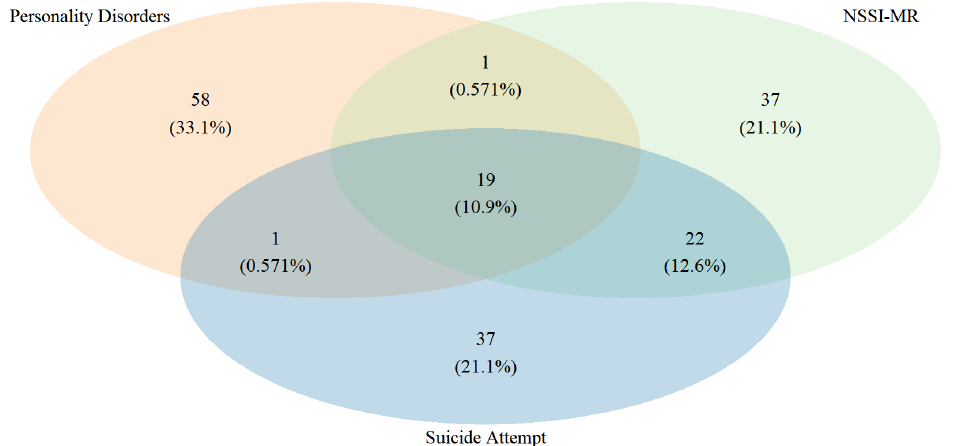
Figure 1. The Venn diagrams shown the logical relation between NSSI behavior, suicide attempts, and personality disorders in the sample (n = 79). NSSI-MR: Non-suicidal self-injury major repeater (NSSI > 20 times life span).